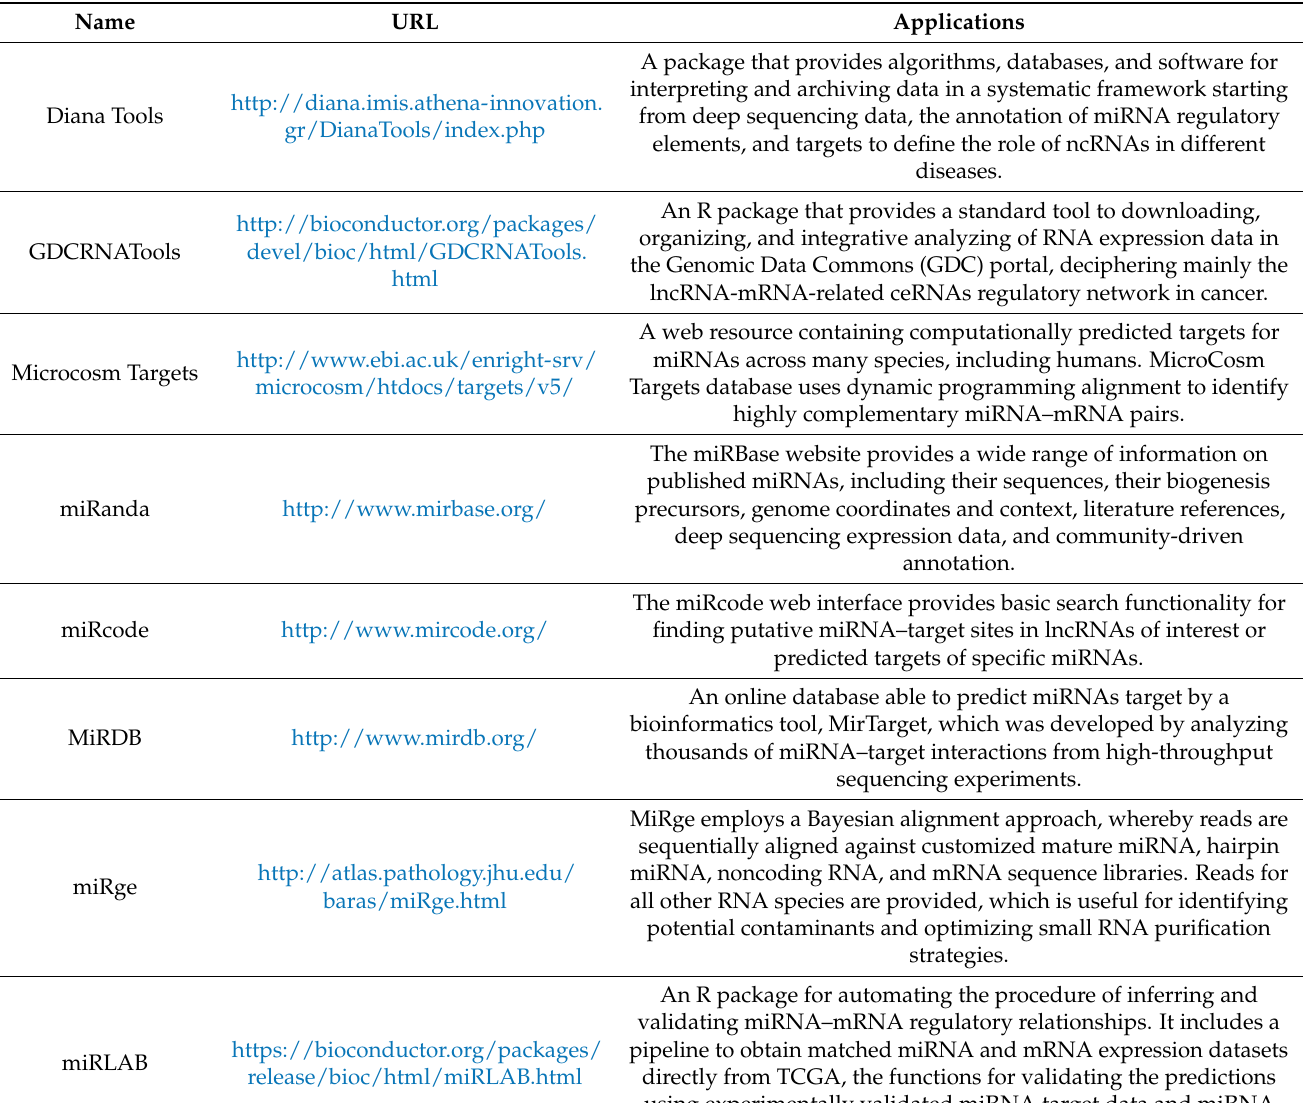
Table 2. Most used bioinformatic tools for miRNA/lncRNA sequence-based